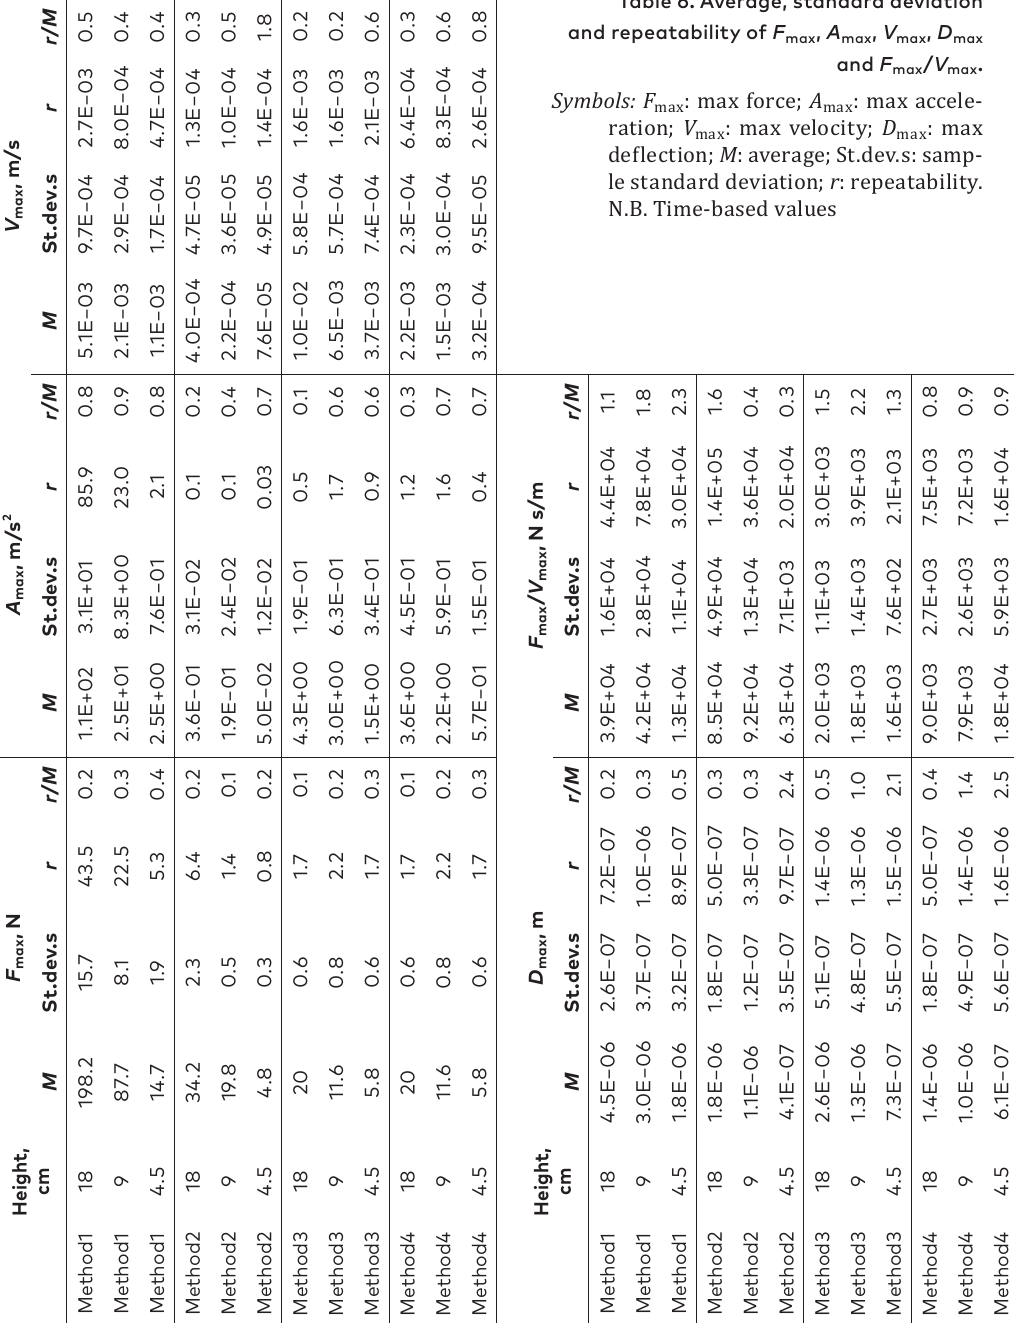
Table 6. Average, standard deviation and repeatability of F max , A max , V max , D